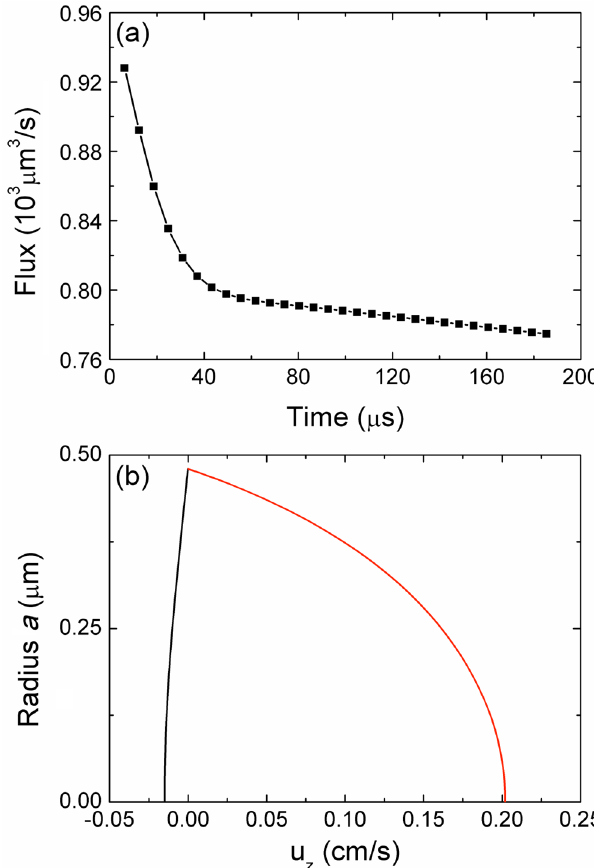
FIG. 10. The EO effect, calculated with a step-function elec- trical field. (a) The time dependence of the EO effect, showing a pulse of fluid flux followed by a quick decay to a smaller value. (b) The axial velocities of the positive (red line) and negative (black line) charges, at t ¼ 182 μ s . It is seen that the trapped surface charges essentially remain stationary, mainly owing to the nonslip hydrodynamic boundary condition. Hence, it resembles a Stern layer. However, the application of the Navier boundary condition for the NS equation can modify the picture. Here, the red line is obtained as the solution of the NS equation with − ep ∇ φ as the driving force density, whereas the black line is that with þ en ∇ φ as the driving force density. Since n has a small value at the center of the channel, the forcing term is small, and hence the related velocity is small as well. It is seen that the sum of the two curves yields a positive EO